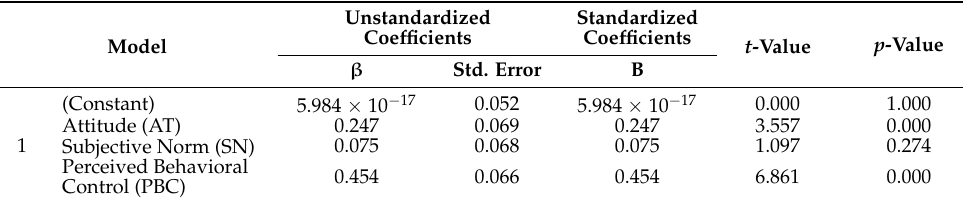
Table 6. Coefficients for Regression Analysis.